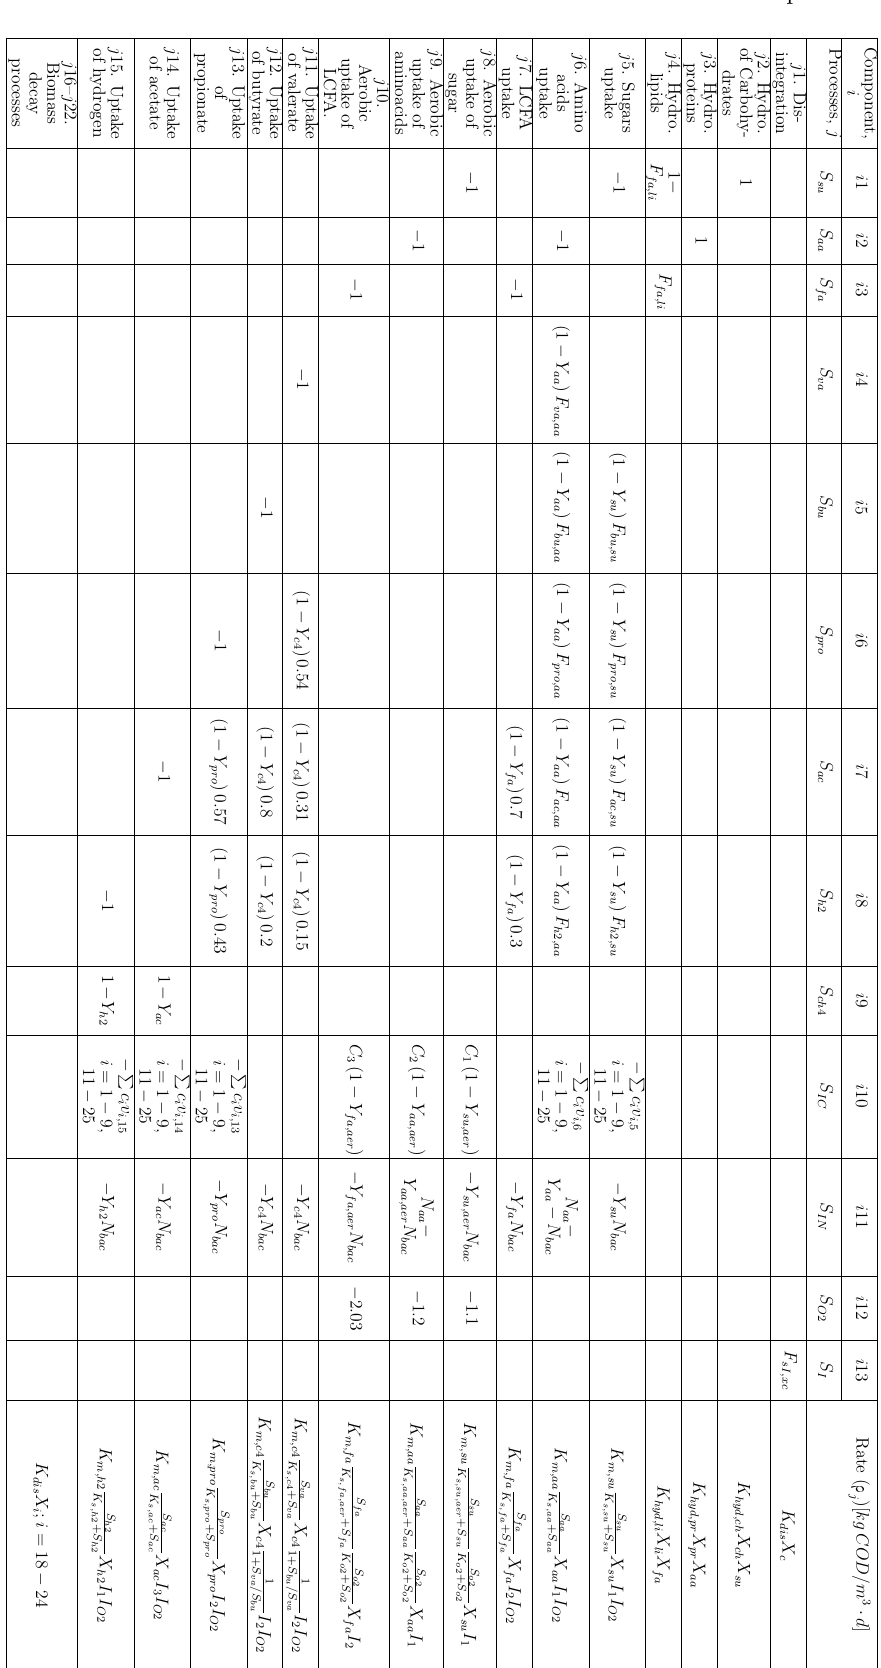
Table 1: Stoichiometric matrix of the ADM1-Ox Model for soluble